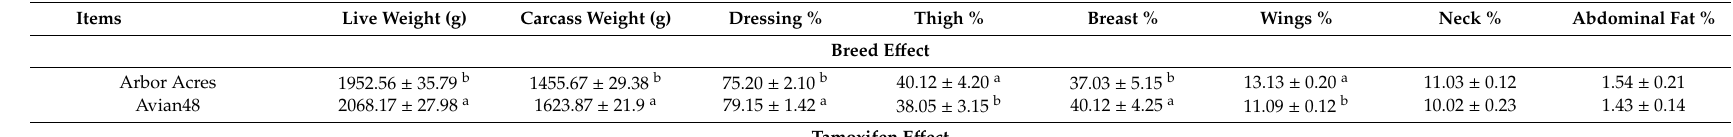
Table 9. The e ff ect of breed, Tamoxifen treatments and their interactions on final weight, carcass weight, dressing% and relative carcass cuts percentages to carcass weight (Means ±